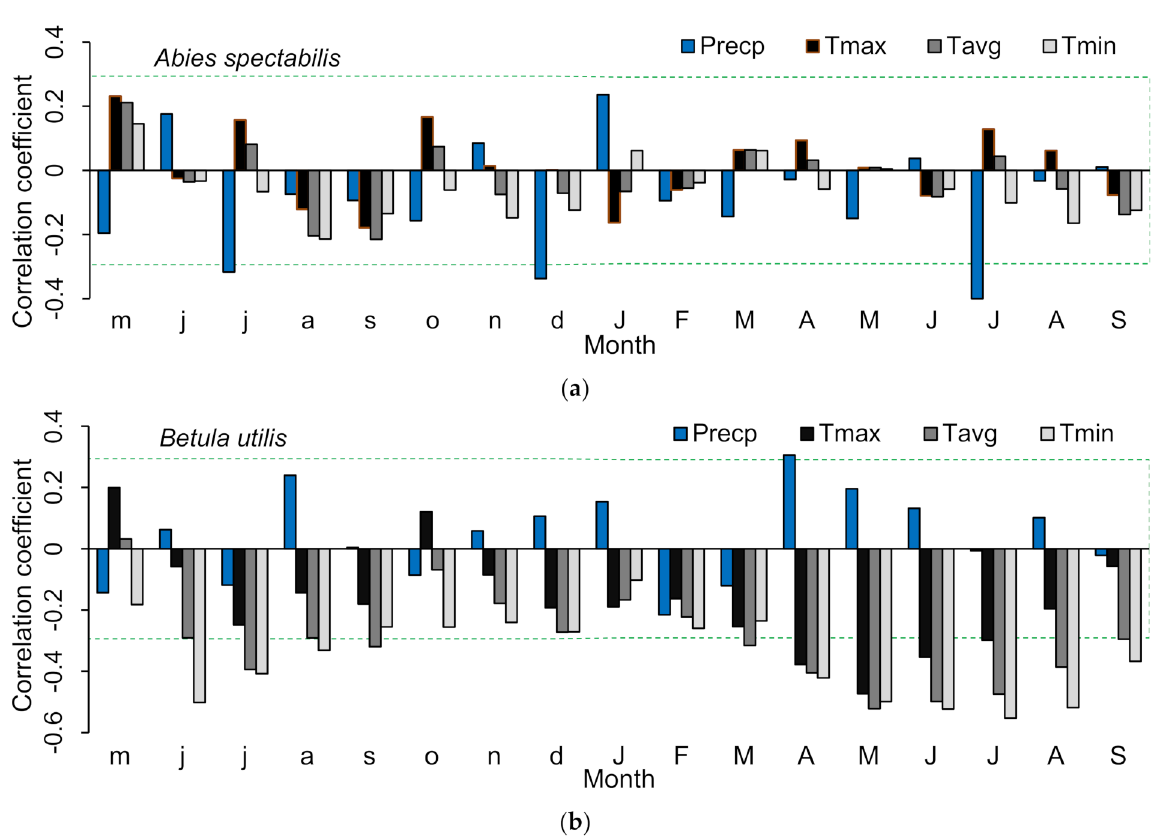
Figure 6. Static radial growth-climate relationships of ( a ) Abies spectabilis and ( b ) Betula utilis for common period of 1970– 2015. The upper and lower horizontal green dashed lines for both plots denotes the significance at 0.05. Lowercase and uppercase letters on x -axis represent previous year’s and current year’s months, respectively. Precp = precipitation, Tmax = maximum temperature, Tavg = mean temperature, and Tmin = minimum